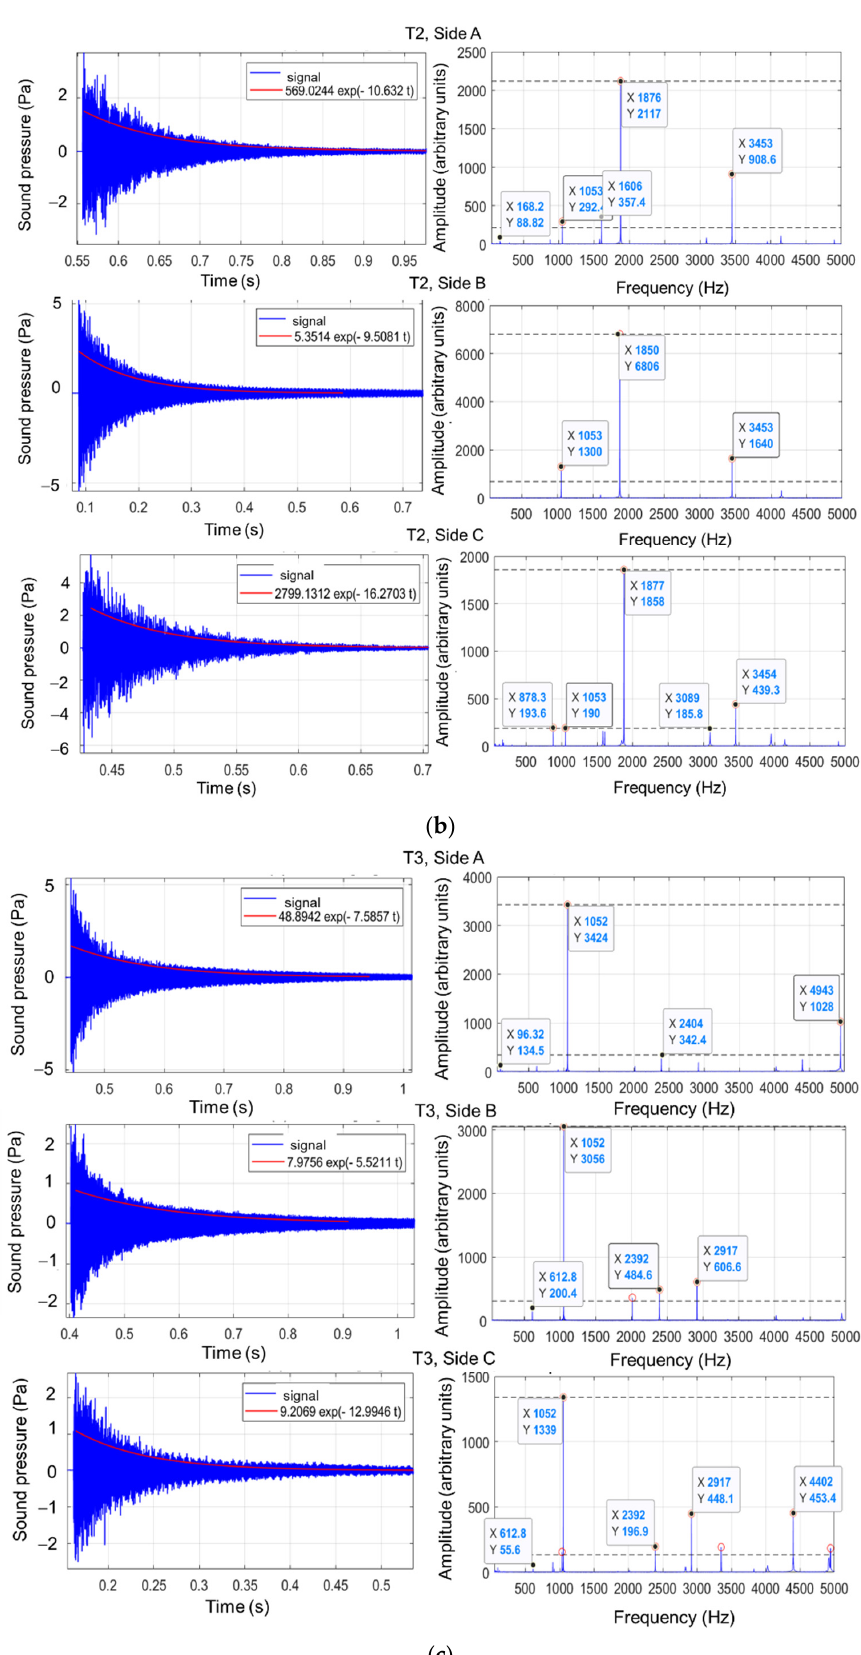
Figure 5. Time and frequency analysis: ( a ) triangle T1; ( b ) triangle T2; ( c ) triangle